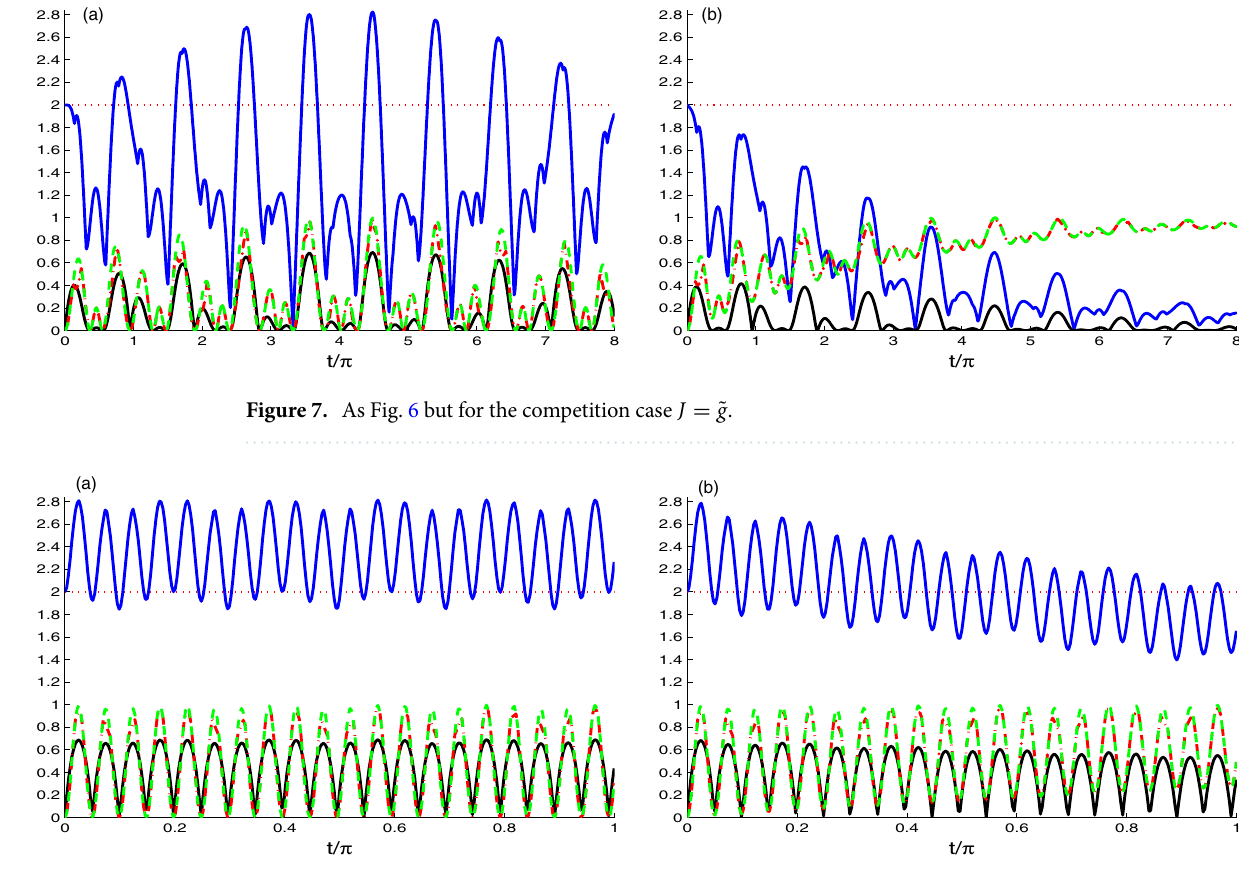
Figure 8. As Fig. 6 but for the case of the hopping coupling between the cavities grater than the coupling strength between the N-V centers, where J